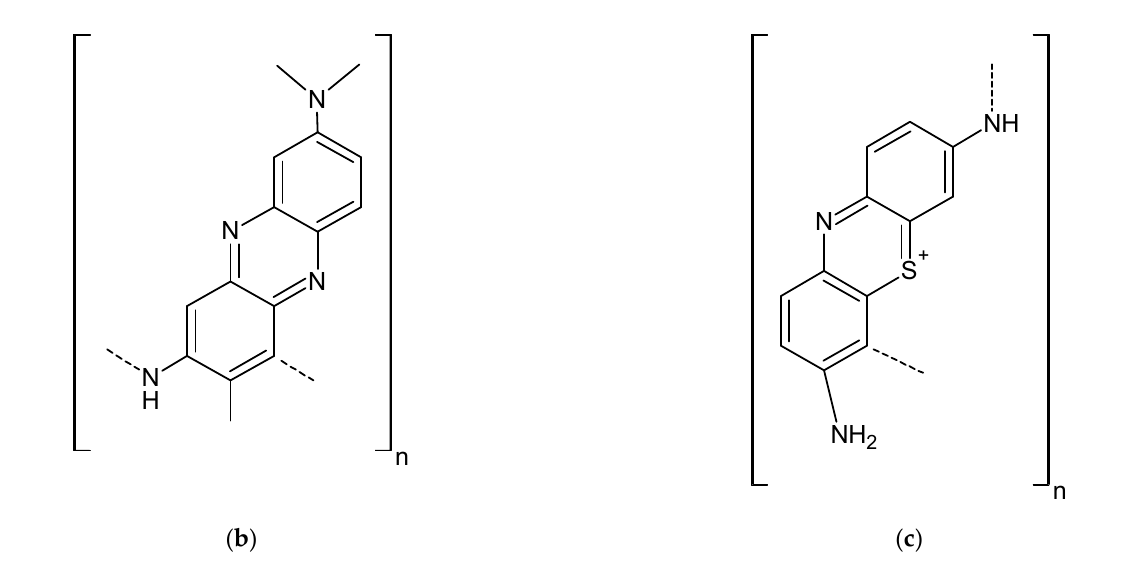
Figure 1. Structure of ( a ) polyaniline (PANI) [31], ( b ) poly(neutral red) (pNR), ( c ) poly(thionine) (pTN) obtained by electrochemical polymerization.